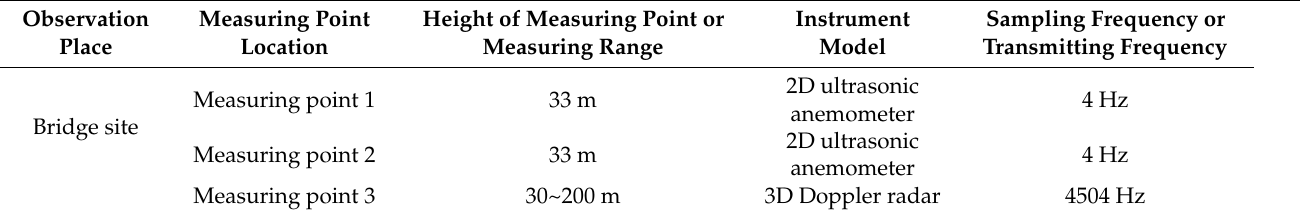
Table 1. The instrument